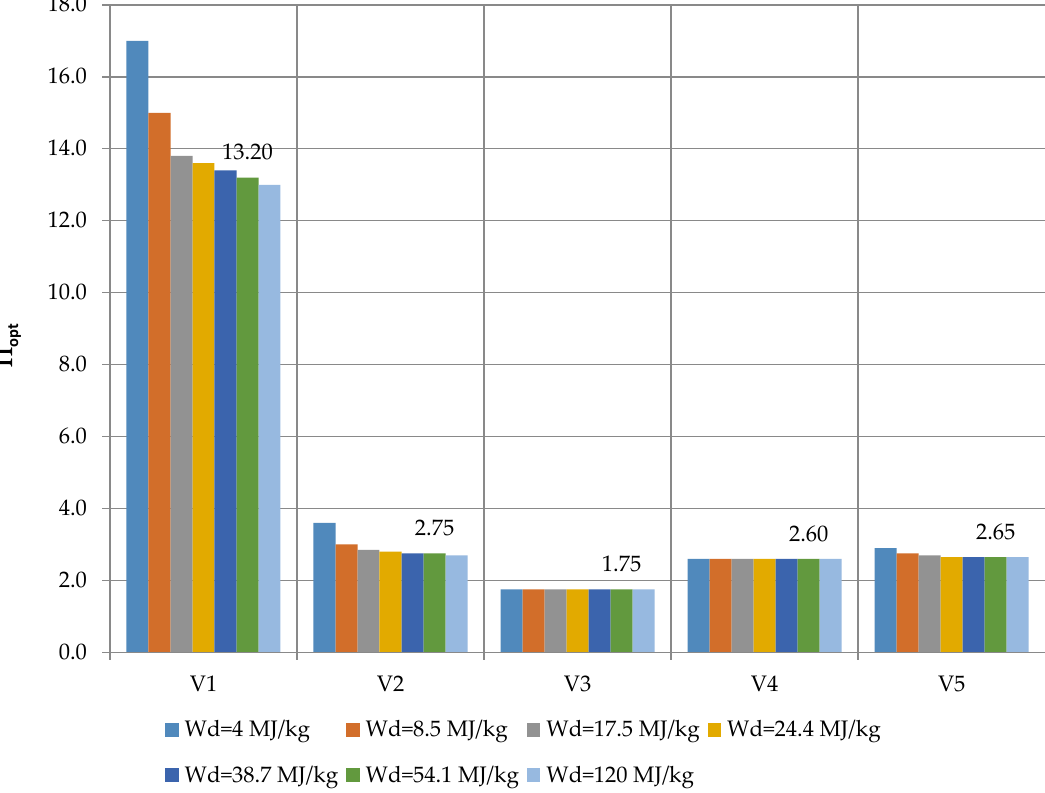
Figure 3. Influence of the structure of the cycle and calorific value of fuel on the optimal compression.